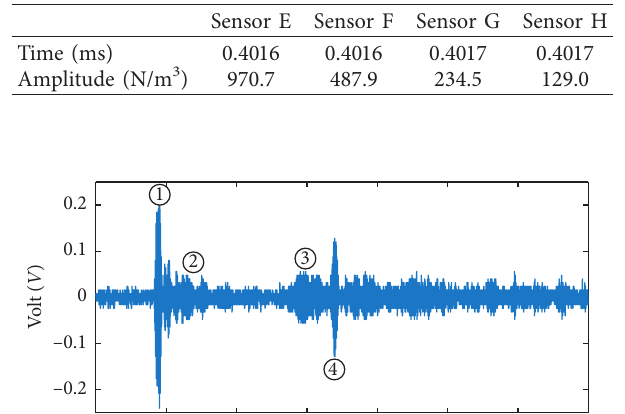
Table 3: The data of signal 3 in the weld seam.